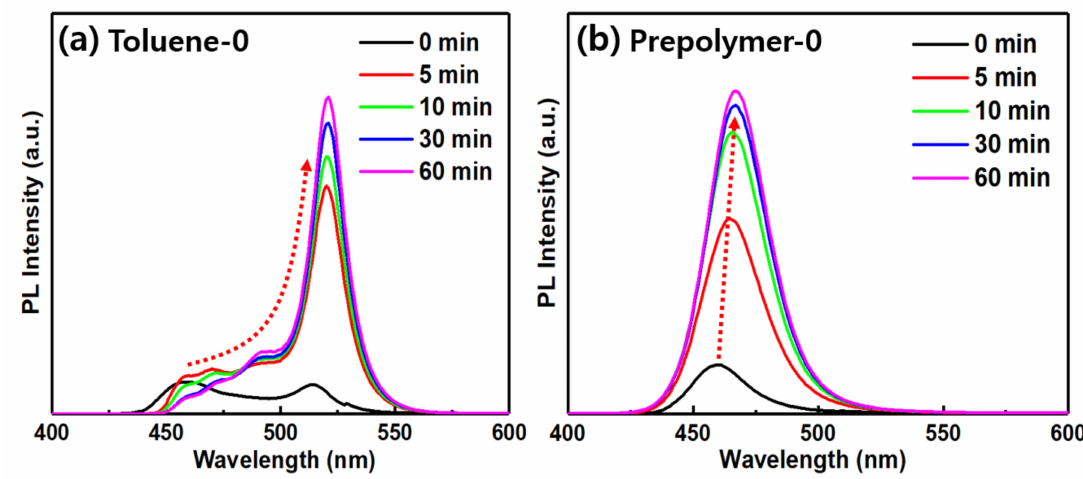
Figure 4. PL spectra as a function of reaction time after dropping in the precursor for the ( a ) toluene-0 and ( b ) prepolymer-0 samples.